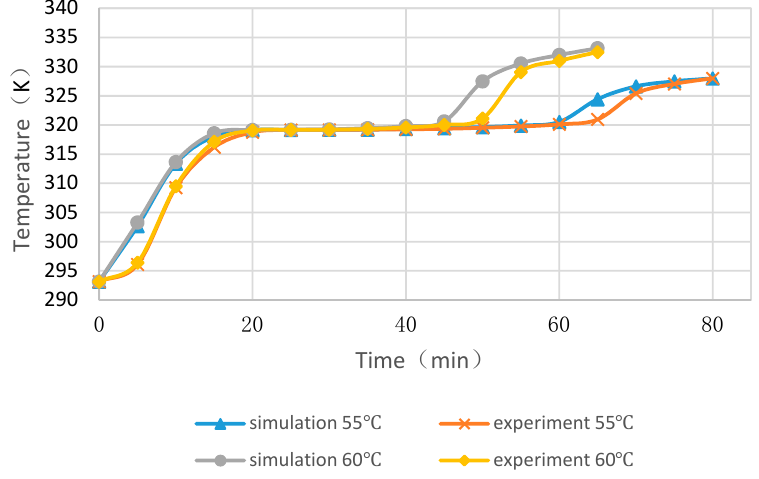
Figure 9. Experimental and numerical results of middle temperatures of PCM cylinder modules when the diameter is 40 mm .